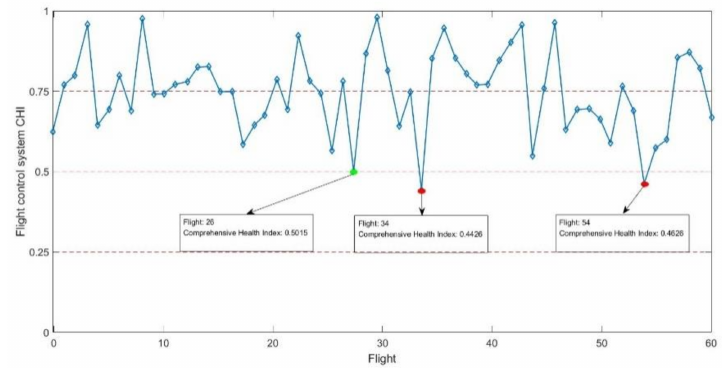
Figure 7. The CHI of flight control system.